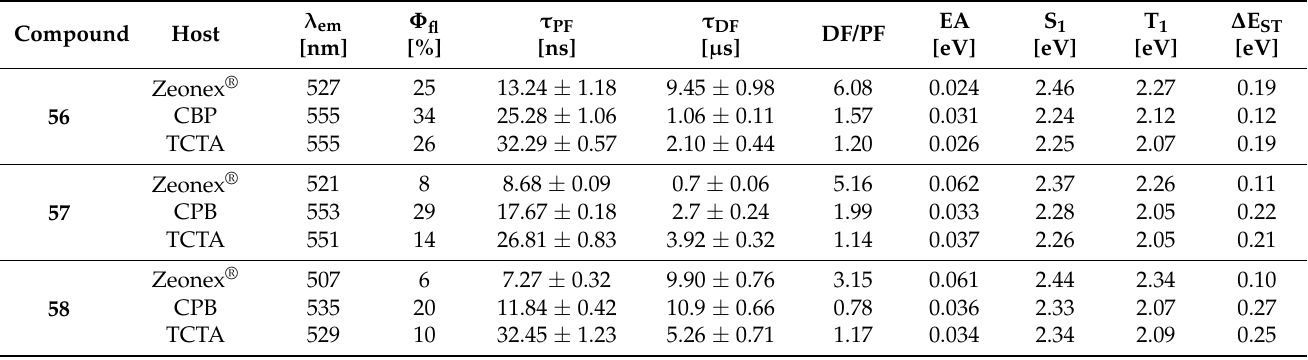
Table 10. The photophysical properties of the compounds 56 – 58